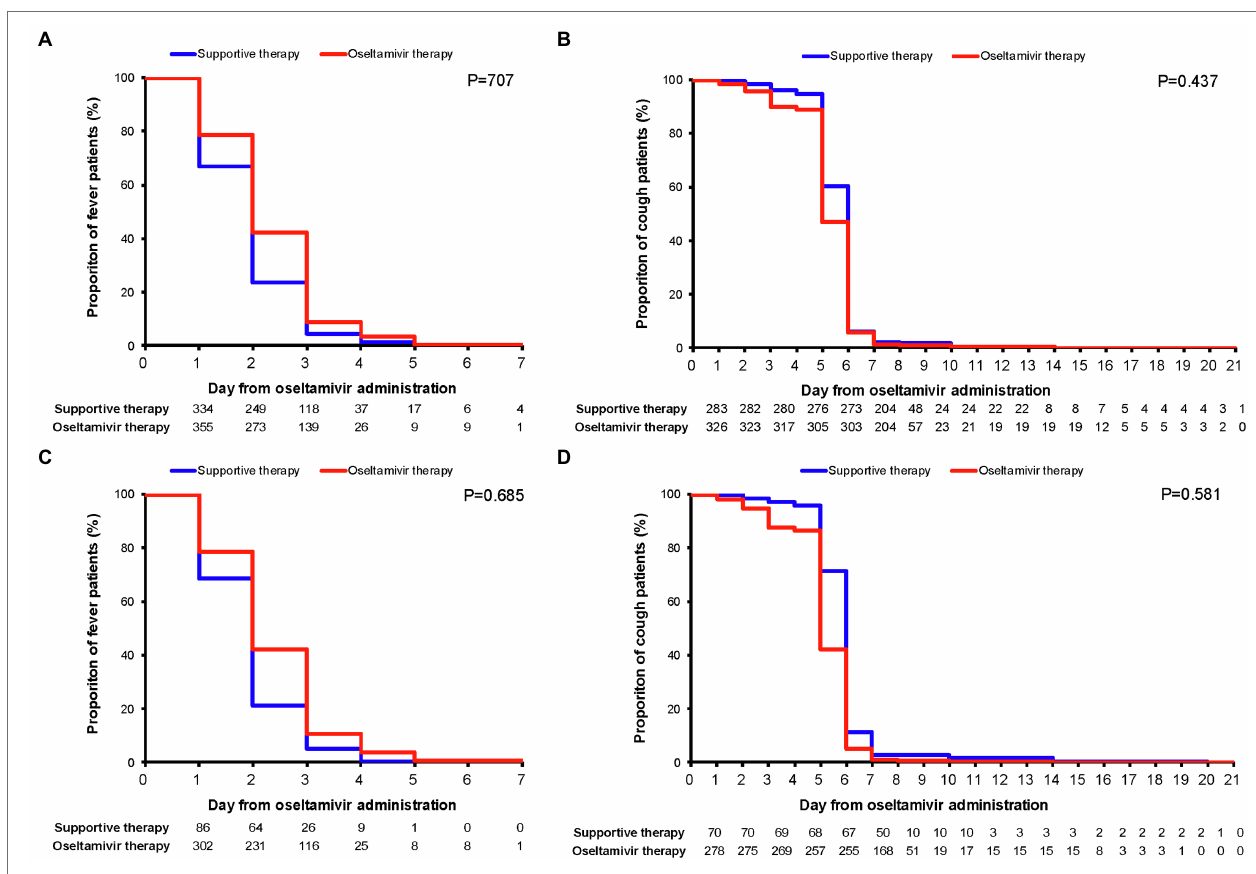
FIGURE 2 | Kaplan–Meier plots for the remission of fever and cough. Comparisons (value of p ) between the oseltamivir therapy and supportive therapy groups were performed with the log-rank test when adjusted for the variables of age, sex, underlying diseases, smoking, high-risk population, WBC group, mononuclear cell group, and neutrophils group. (A) Fever duration in ILI patients; (B) cough duration in ILI patients; (C) fever duration in influenza virus-positive patients; and (D) cough duration in influenza virus positive patients. WBC, white blood cell and ILI, influenza-like